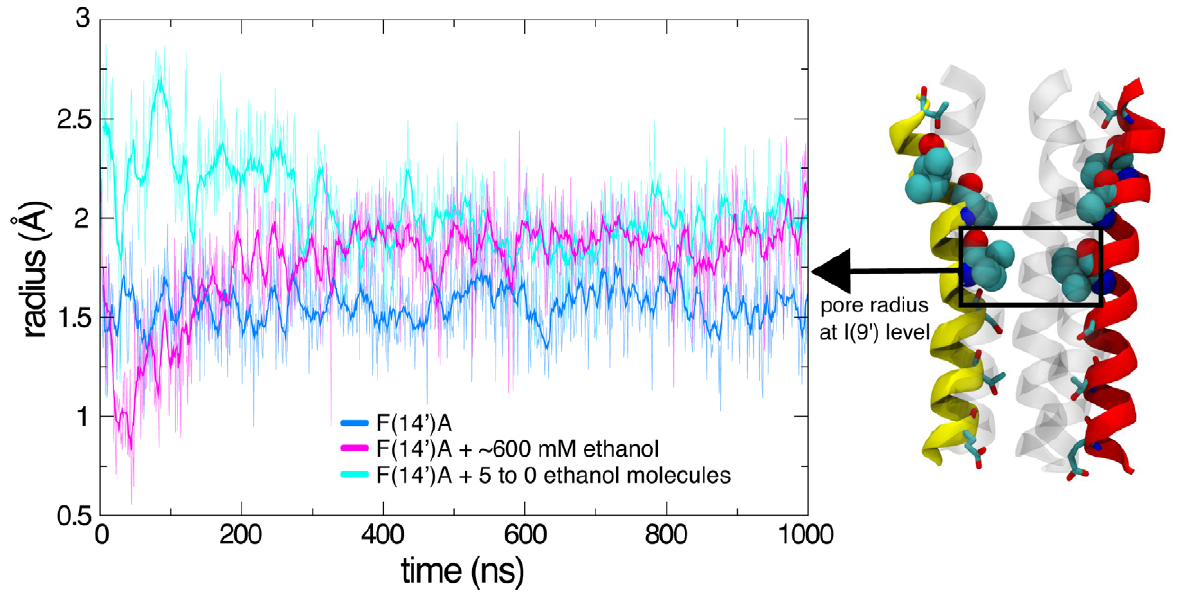
Figure 7. Effects of spontaneous and constrained ethanol binding on pore constriction. Minimal pore radius at the hydrophobic barrier at I(9 9 ) as a function of time for F(14 9 )A simulations without ethanol (blue), with 600 mM ethanol (purple), and with one ethanol molecule constrained in each of the five inter-subunit cavities (cyan), computed by extracting the smallest pore radius around I(9) 9 with a z-window of 5 A˚. In the constrained system, one ethanol molecule was removed every 100 ns between 500 and 1000 ns.